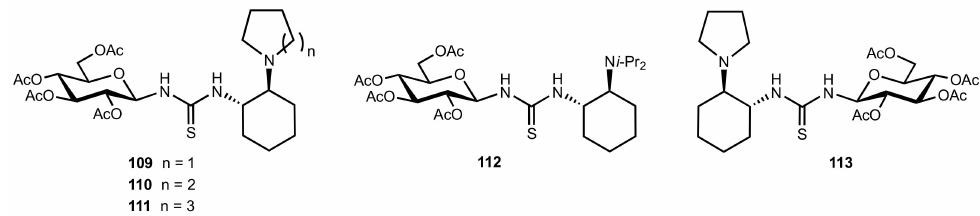
Figure 12. The structure of catalysts 109–113 .